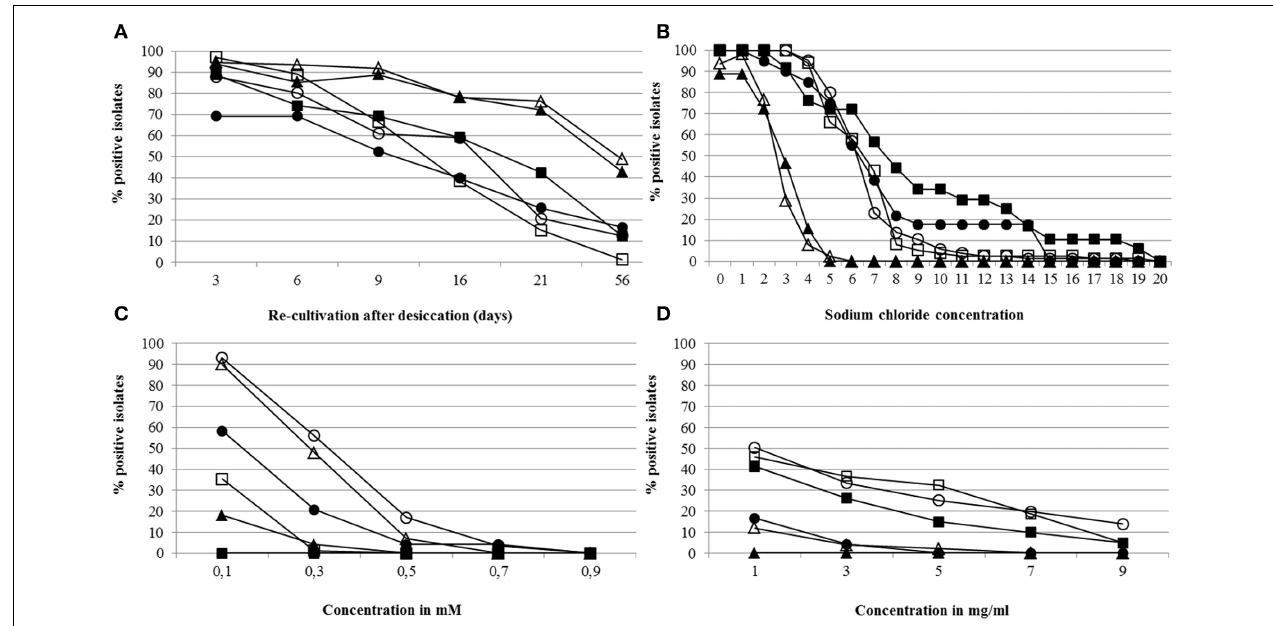
FIGURE 3 | Stress tolerance assays. Bacterial isolates able to be re-cultivated after desiccation (A) , grown in presence of different sodium chloride concentrations (B) , and cultivated in presence of reactive oxygen species caused by hydrogen peroxide (C) and tellurite (D) . In total, 357 antagonistic bacteria, previously selected from R2A or Kings B medium, were